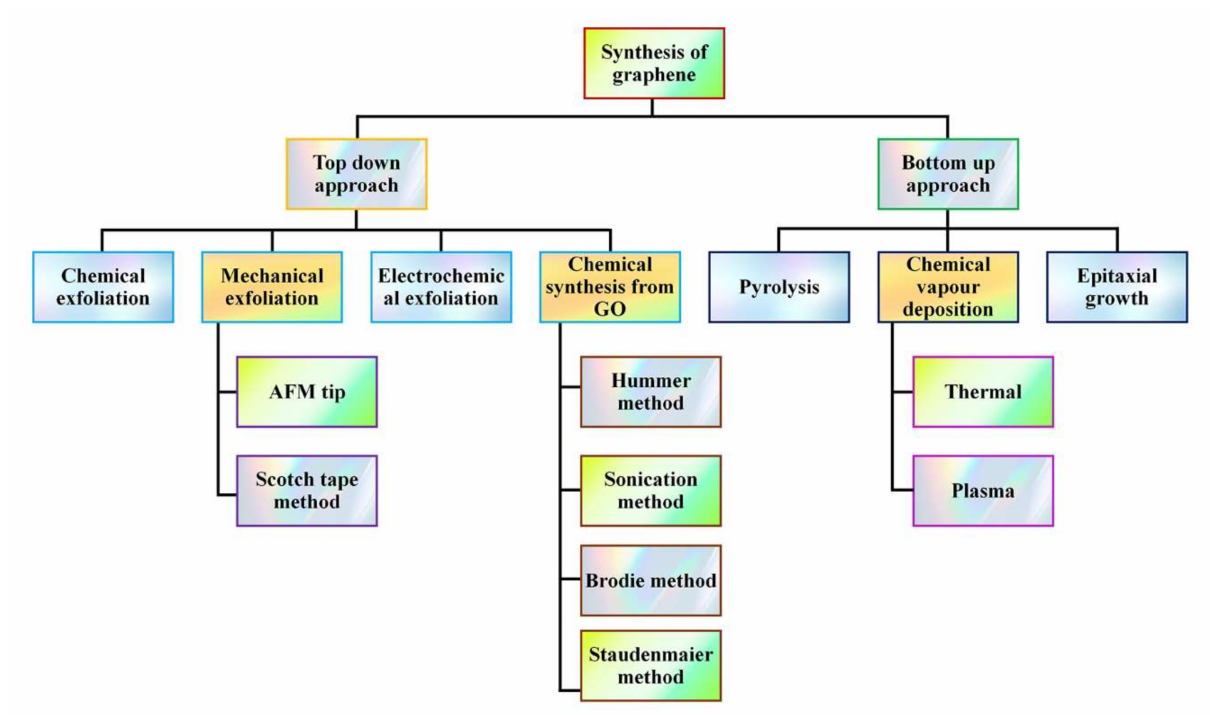
Figure 4. Flow chart representing the synthesis procedure of